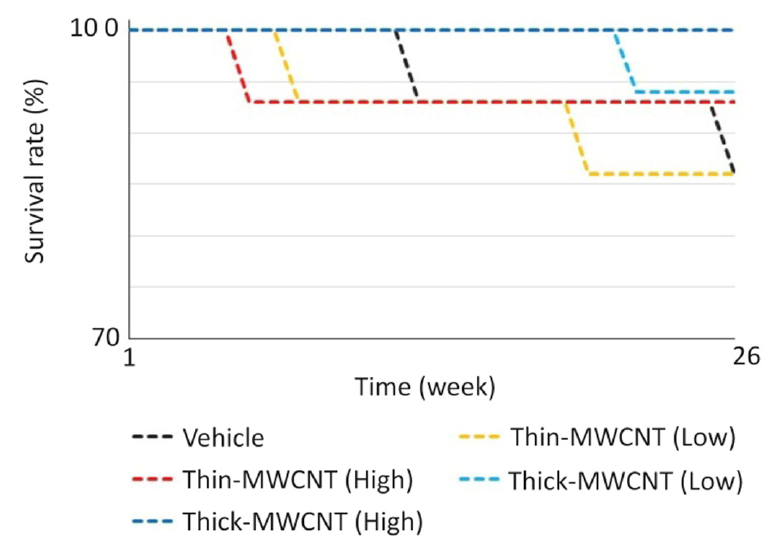
Figure 4. Survival curve of rasH2 mouse with intravenous administration of MWCNTs. The experiment was performed with n = 15 in each group. Even in the group without MWCNT administration, no significant difference was found between the vehicle group and the mortality rate. Image is modified from a study by Sobajima et al. [94].